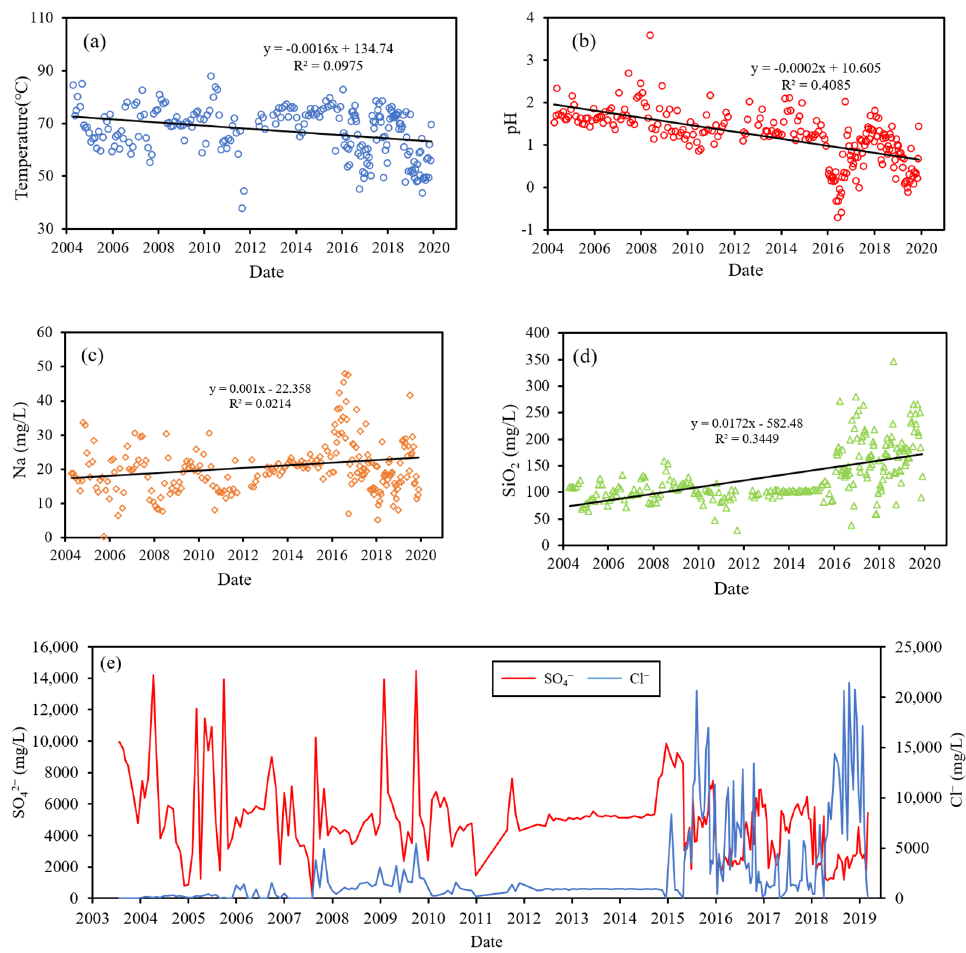
Figure 2. Temporal variation of ( a ) temperature, ( b ) pH, ( c ) Na concentration, ( d ) SiO 2 concentration, and ( e ) Cl − and SO 42 − concentration of Tayukeng (TYK) thermal